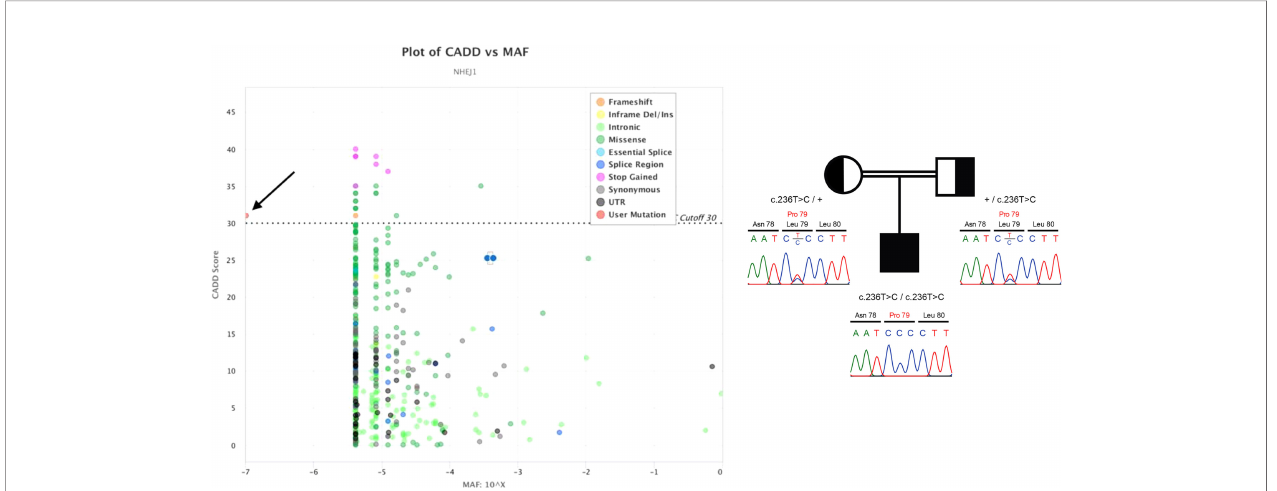
FIGURE 1 | Left: CADD versus minor allele frequency (MAF) plot of all known NEHJ1 sequence variants visualized by PopViz (18). The horizontal axis shows the MAF scores and the vertical axis the CADD ones. The speci fi c types of the various sequence variants, which were collected from the gnomAD r2.0.2 database (https://gnomad.broadinstitute.org/gene/ENSG00000187736?dataset=gnomad_r2_1), are color-coded, and the pathogenic variant of our patient is indicated by the black arrow. Right: The patient ’ s homozygous NEHJ1 gene pathogenic variant (NM_024782.2:c.236T>C, p.Leu79Pro) was inherited from his heterozygous